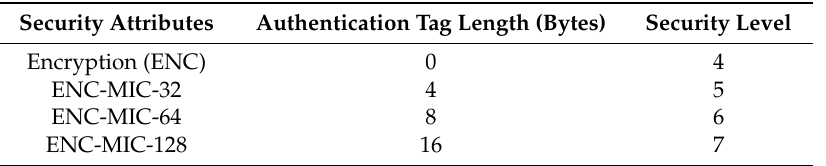
Table 1. Security levels provided by the IEEE802.15.4